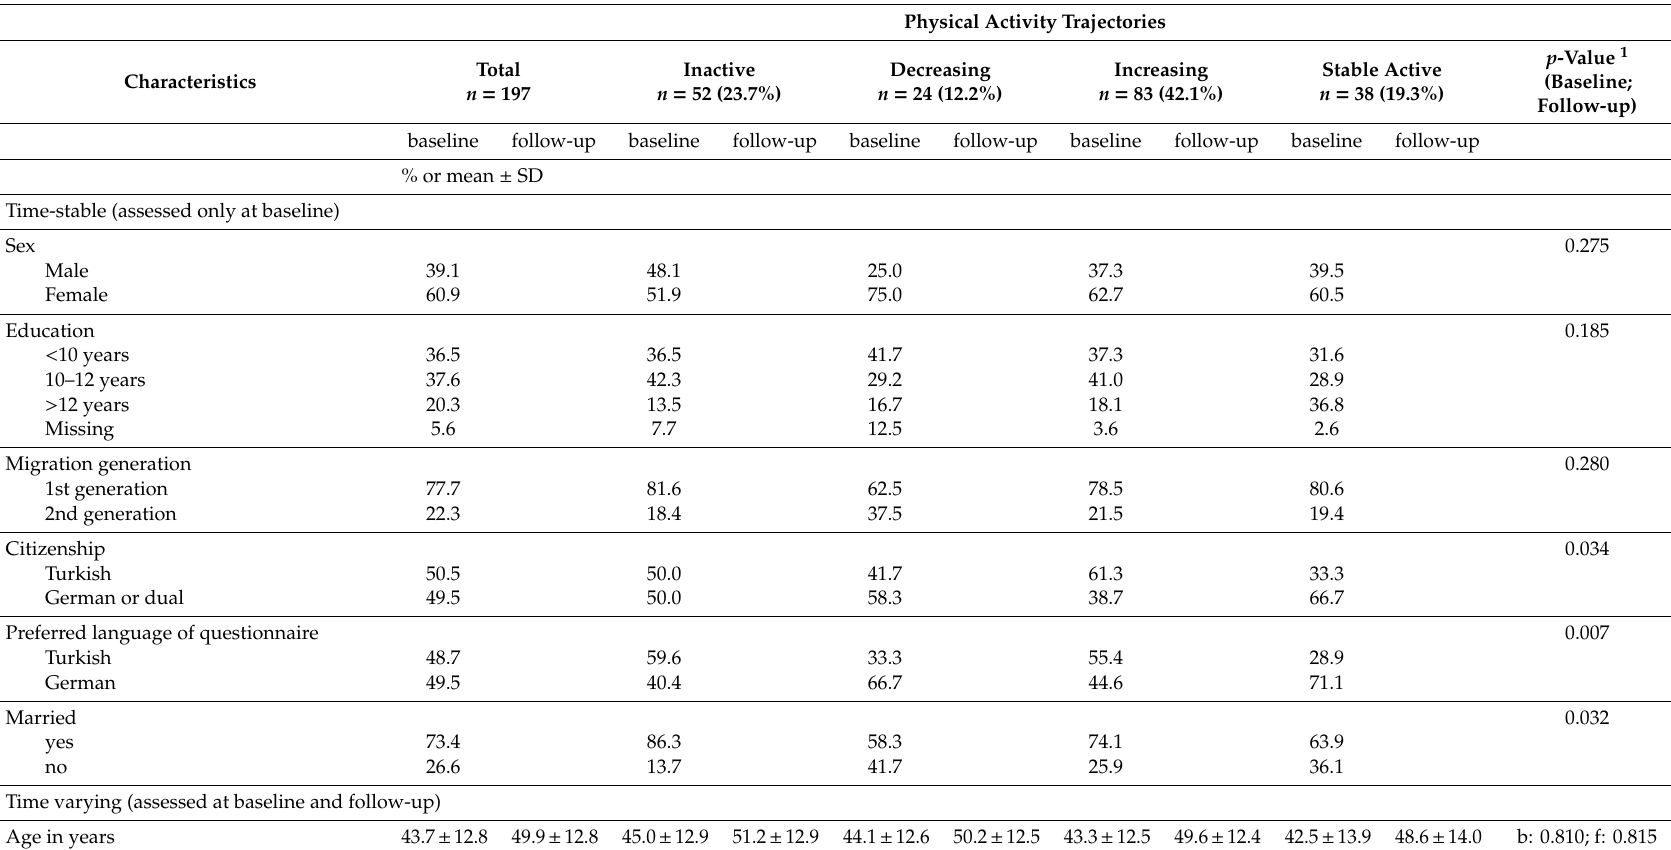
Table 1. Characteristics of total sample and physical activity (PA)